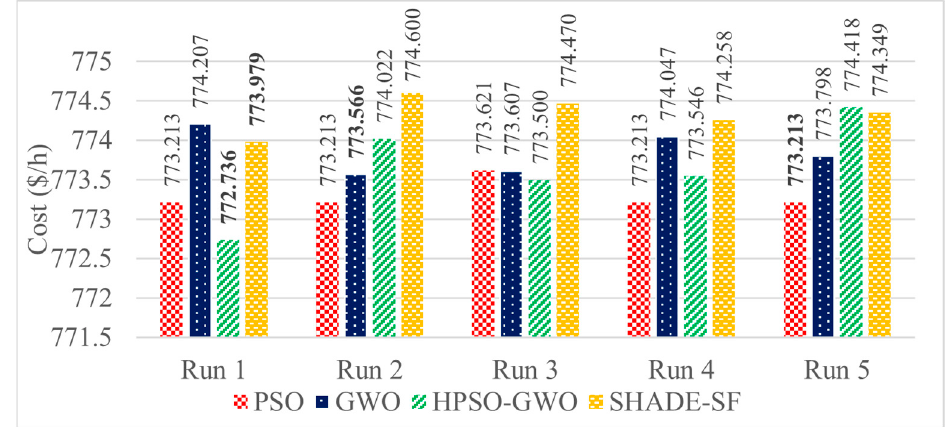
Figure 18. Cost comparison of 5 runs (Case 3). Table 5. Simulation results for Case 3.